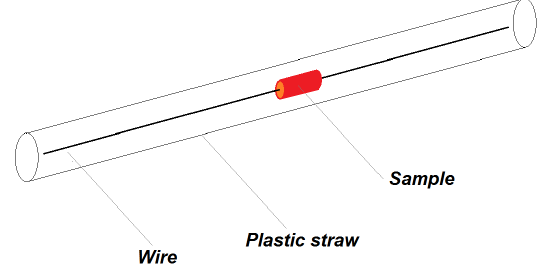
Figure 8. Schematics of the sample configuration in holder with copper wire and a plastic straw.